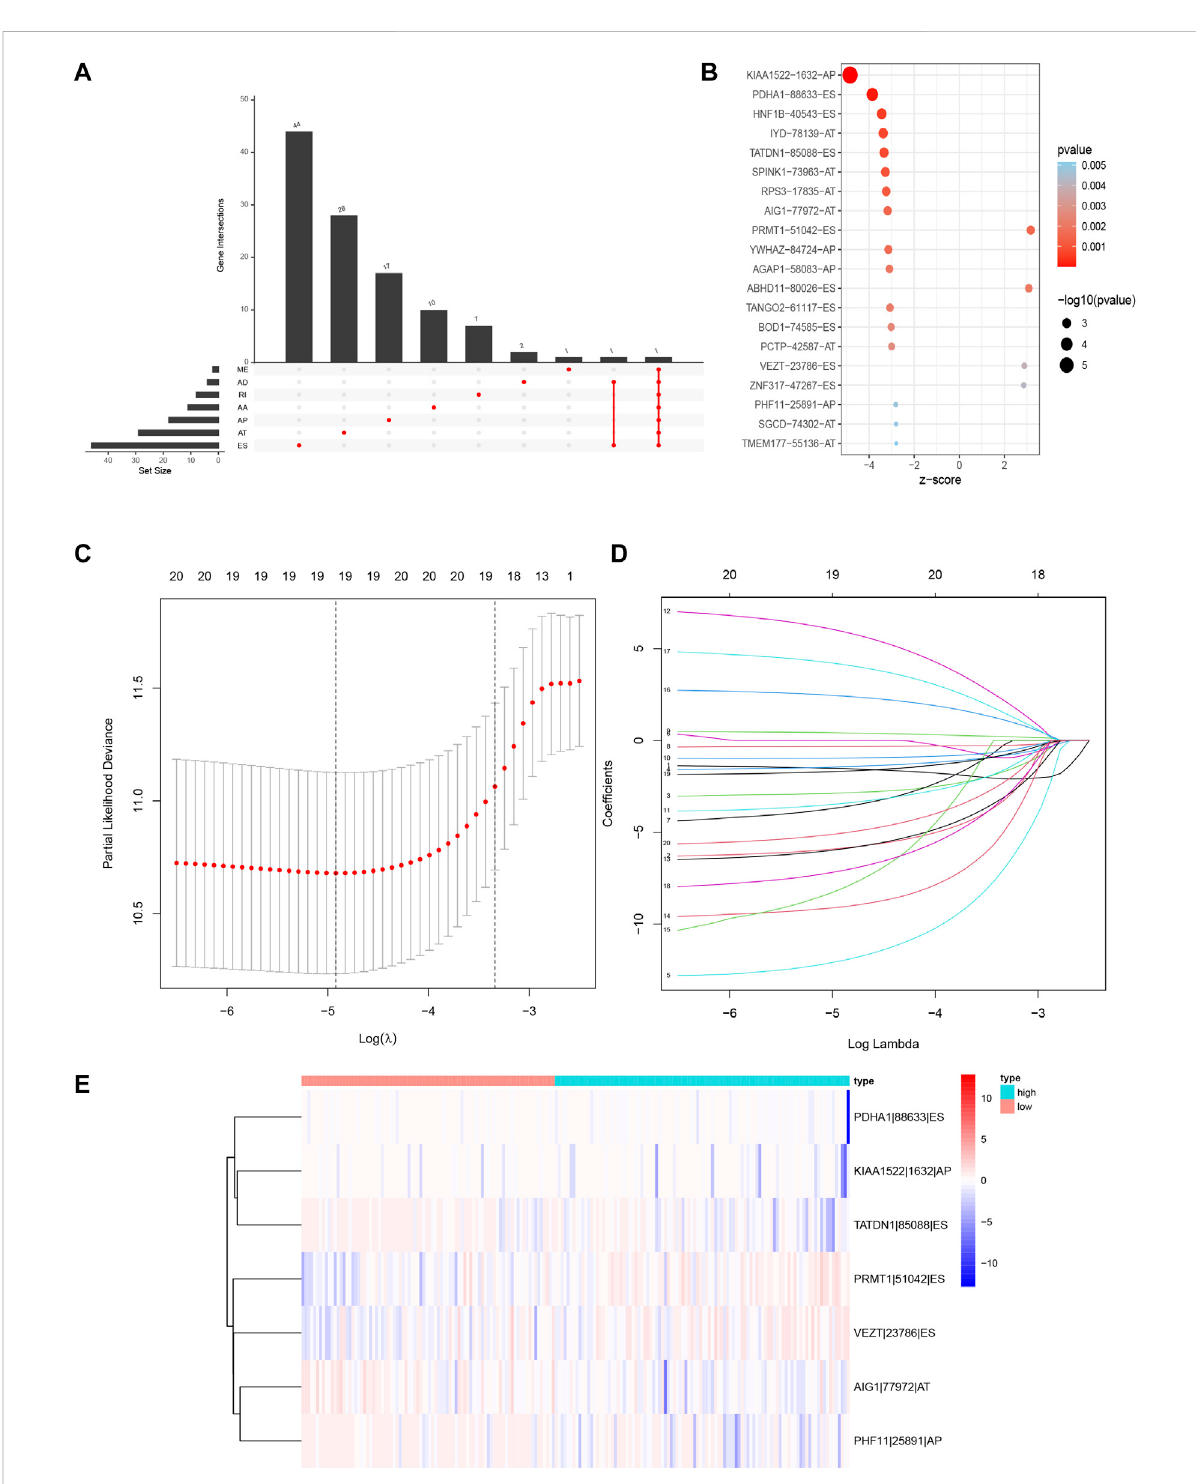
FIGURE 3 Prognosis-relatedASeventsinthisstudy. (A) Upsetplotforsurvival-relatedgenes. (B) TheBubbleplotsofsurvival-associatedASeventsinCRC. (C,D) Optimal survival-related AS events selection in the LASSO regression model. (E) Heat map of the seven optimal survival-related AS events. LASSO, least absolute shrinkage and selection